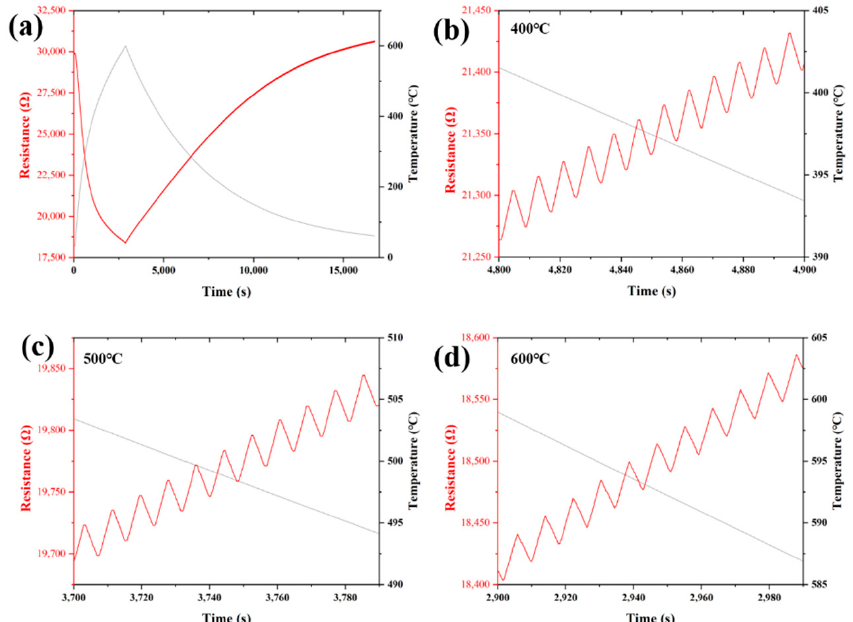
Figure 9. ( a )The cyclic response from 25 °C to 600 °C; ( b ) The cyclic response at 400 °C; ( c ) The cyclic response at 500 °C; ( d ) The cyclic response at 600 °C.